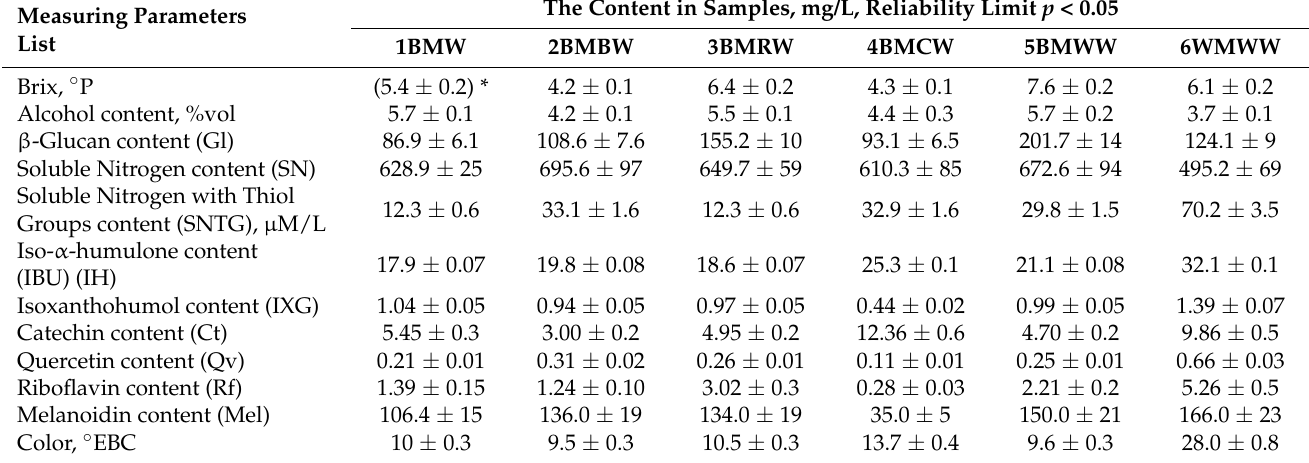
Table 11. The characteristics of beer samples with different